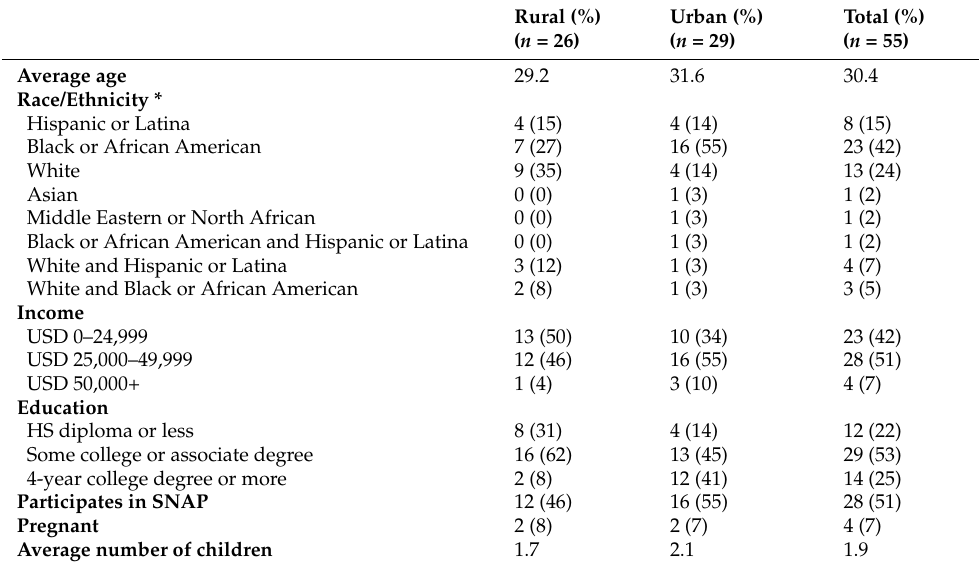
Table 1. Sample Demographic Characteristics ( n =